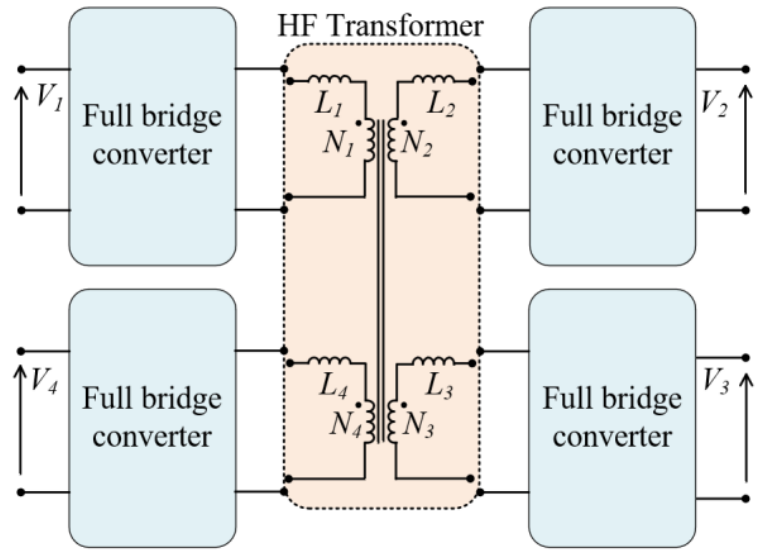
Figure 7. Quadruple-Active-Bridge converter topology.